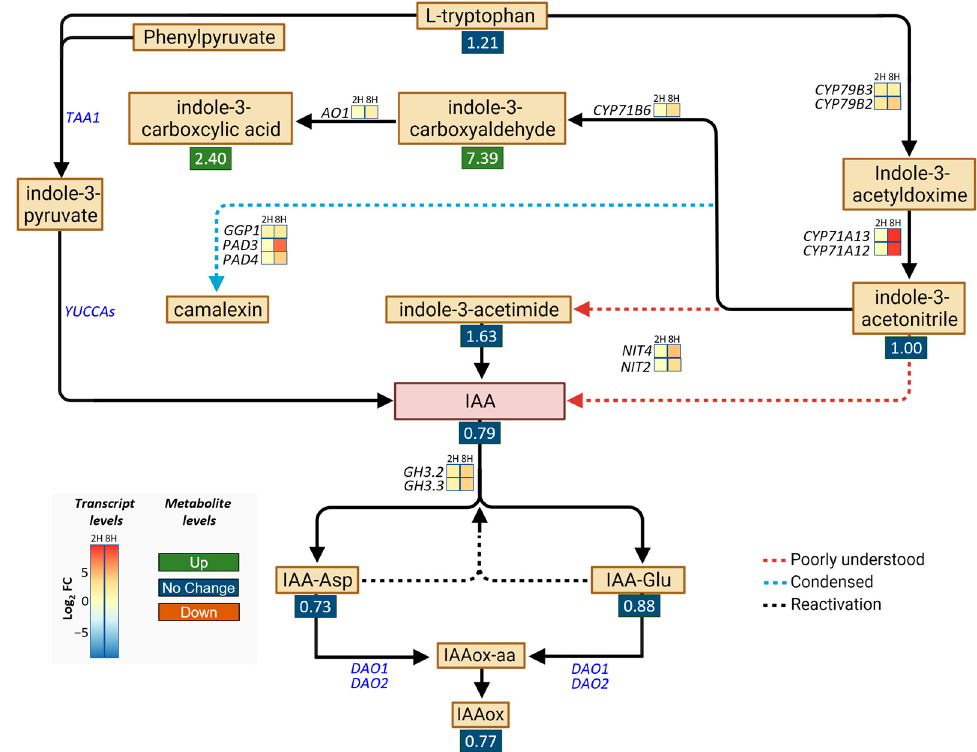
Figure 2. Map of differentially expressed genes (DEGs) and metabolites involved in IAA metabolism. DEGs and their relative expression levels (presented as log2 fold changes (FC)) in seedlings treated for 2 h (2H) or 8 h (8H) with 0 or 50 mM DA are shown as heatmaps. All presented DEGs with a non-zero log2 FC have an FDR < 0.001. The FC in metabolite level in seedlings grown on 0.5 mM DA for 7 days is presented below the metabolites in colored boxes (green, FC ≥ 2, accumulation; red, FC ≤ 0.5, reduced levels; blue, 0.5 ≥ FC ≤ 2, not altered). Red arrows represent poorly understood processes, light-blue dashed arrows represent condensed metabolic steps, and black dashed arrows represent the reactivation of IAA through deconjugation of IAA amino conjugates. Abbreviations: IAA represents indole-3-acetic acid, IAA-Asp represents aspartate-conjugated IAA, IAA-Glu represents glutamine-conjugated IAA, IAAox-aa represents oxidized amino-conjugated IAA, and IAAox represents oxidized IAA.